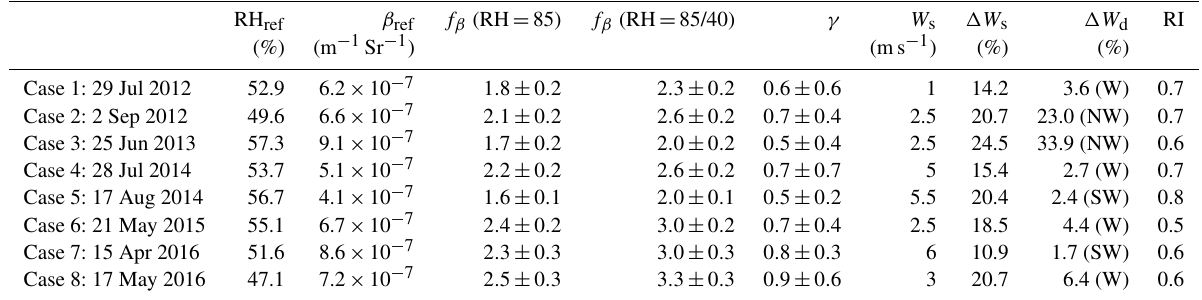
Table 1. Enhancement factor ( f β (RH = 85%)) at RH ref of the case and extrapolated at RH ref = 40%, γ , wind speed, variability of wind speed and wind direction, and the index of variability between (cid:49)f PM the aerosol hygroscopic